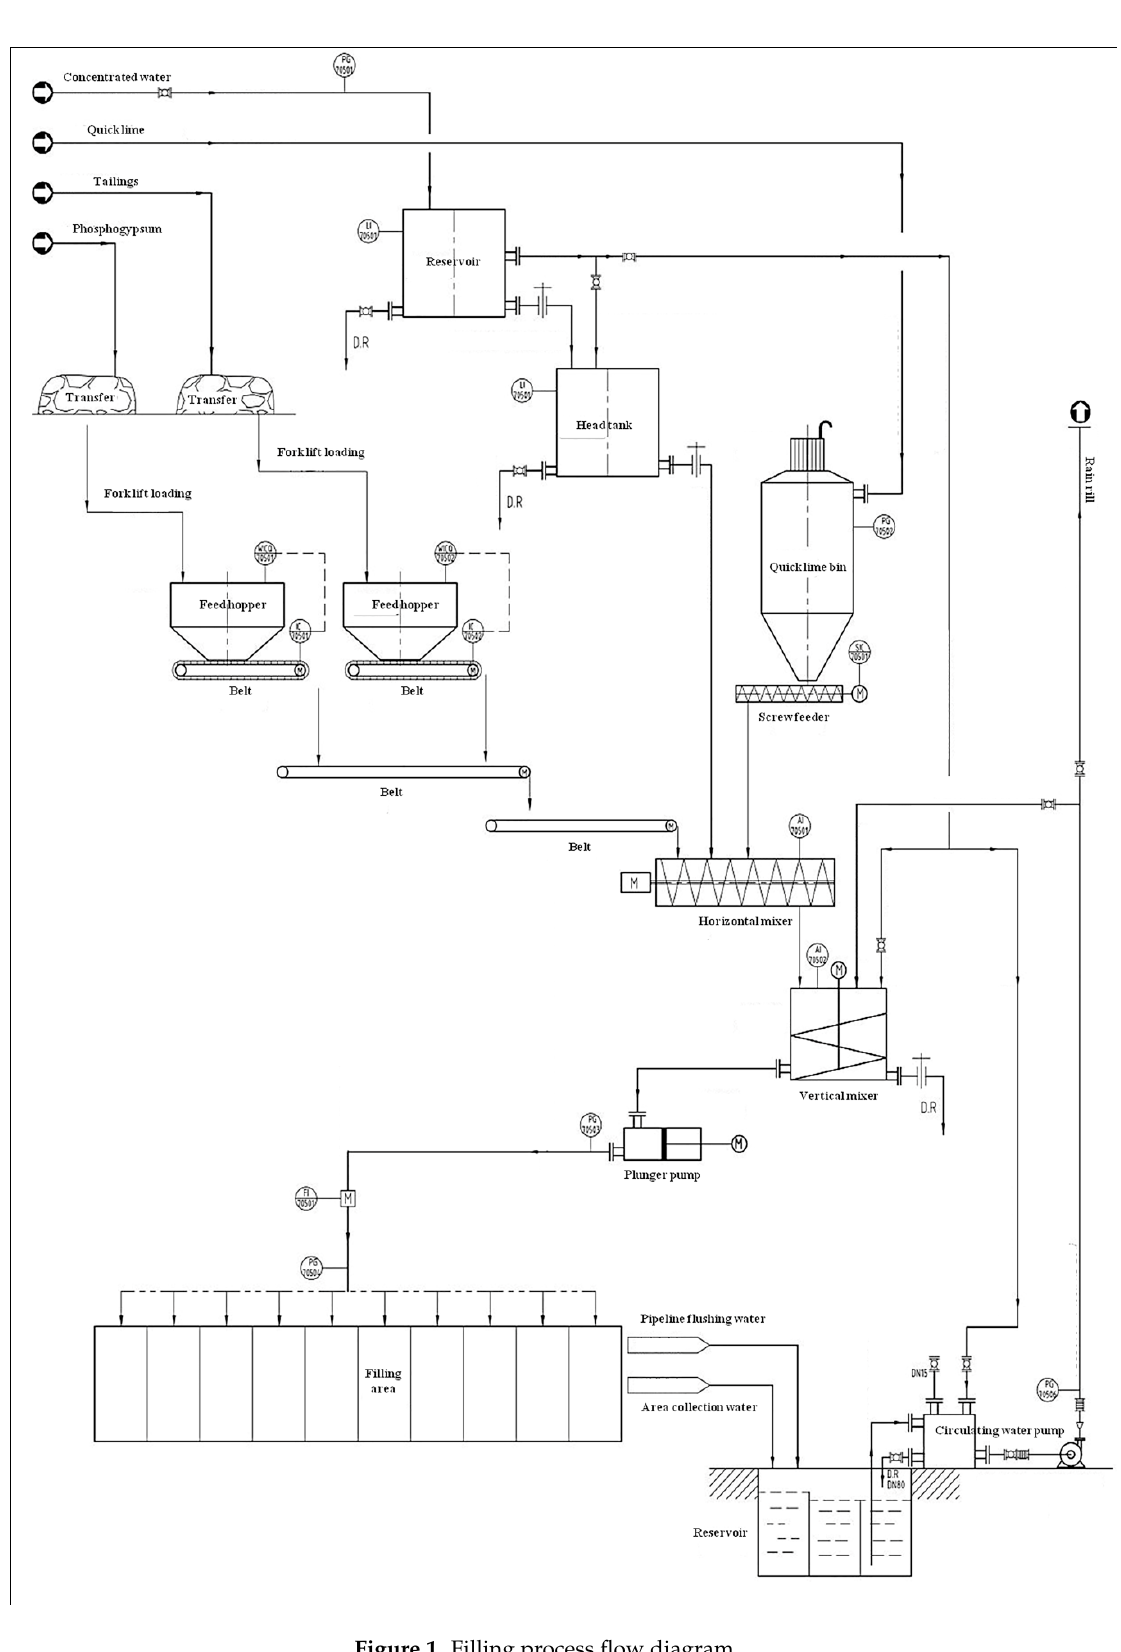
Figure 1. Filling process flow diagram.